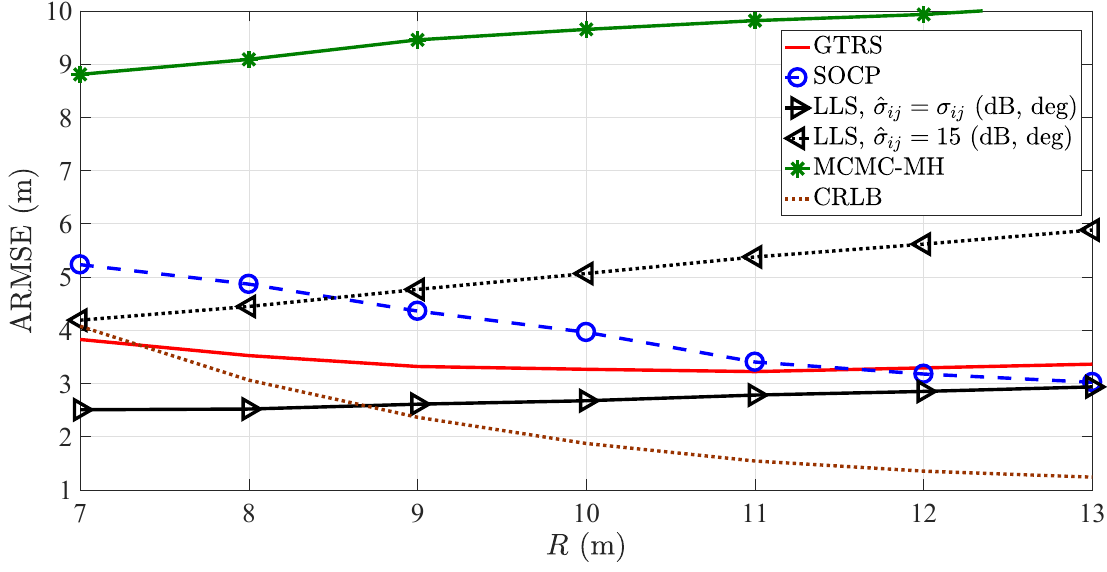
Figure 14. ARMSE (m) versus R (m): N = 15, M = 50, M c =